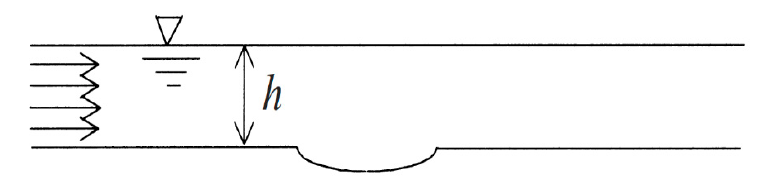
Figure 3. Diagram of the flow over a depression.